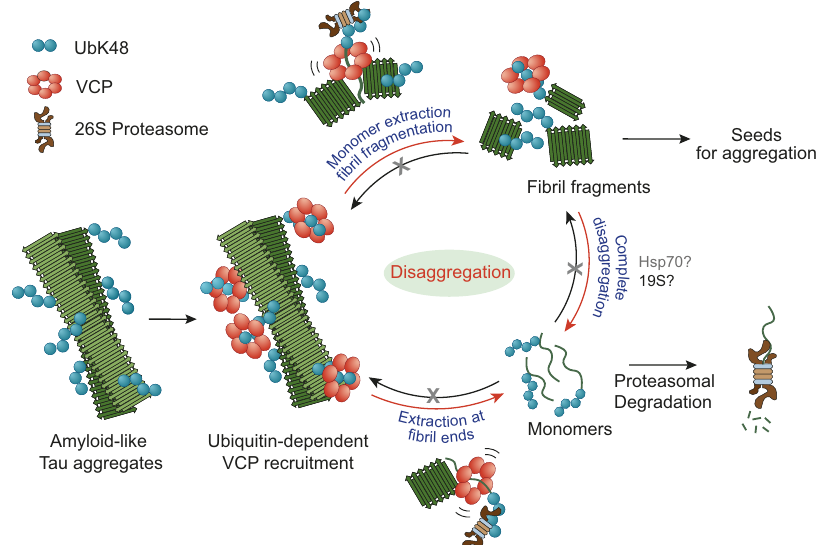
Fig. 7 | Model ofVCP-mediateddisaggregationofamyloid-likeTauaggregates. Modi fi cationofaggregateswithK48-linkedubiquitinchainsallowstherecruitment of VCP. VCP may extract ubiquitylated Tau monomer from fi bril ends or from within fi brils. Monomers are directly targeted for proteasomal